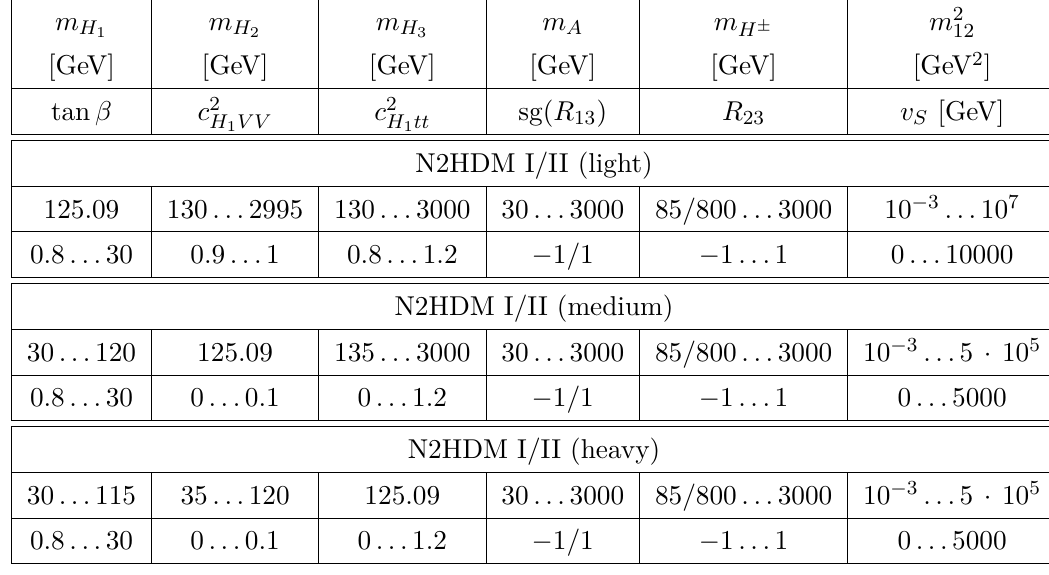
Table 4 . Scan ranges of the N2HDM input parameters, cf. eq. (2.12), where light/medium/heavy refers to the set-up where the lightest/medium/heaviest of the three neutral Higgs bosons is